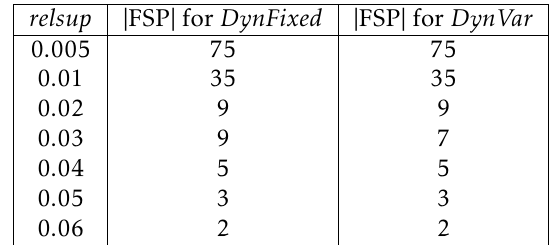
Table 18. Number of frequent subpaths ( | FSP | ) for paths data with varying relative support ( relsup ) for proposed dynamic approach with fixed batch size ( DynFixed ) and variable batch size ( DynVar